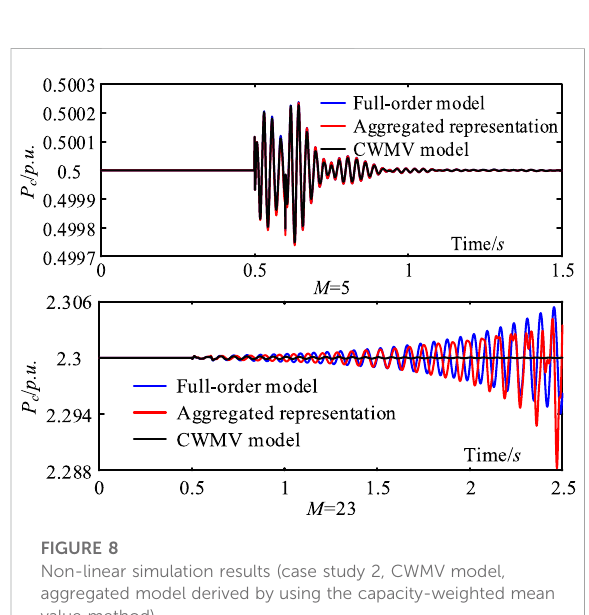
FIGURE 8 Non-linear simulation results (case study 2, CWMV model, aggregated model derived by using the capacity-weighted mean value